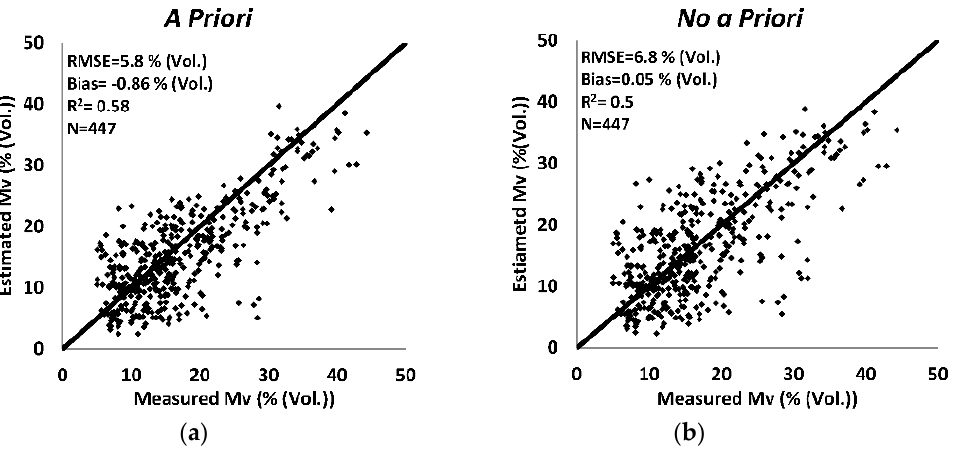
Figure 6. Neural Network simulations for two cases: ( a ) without a priori information; ( b ) with a priori information for the reference fields.